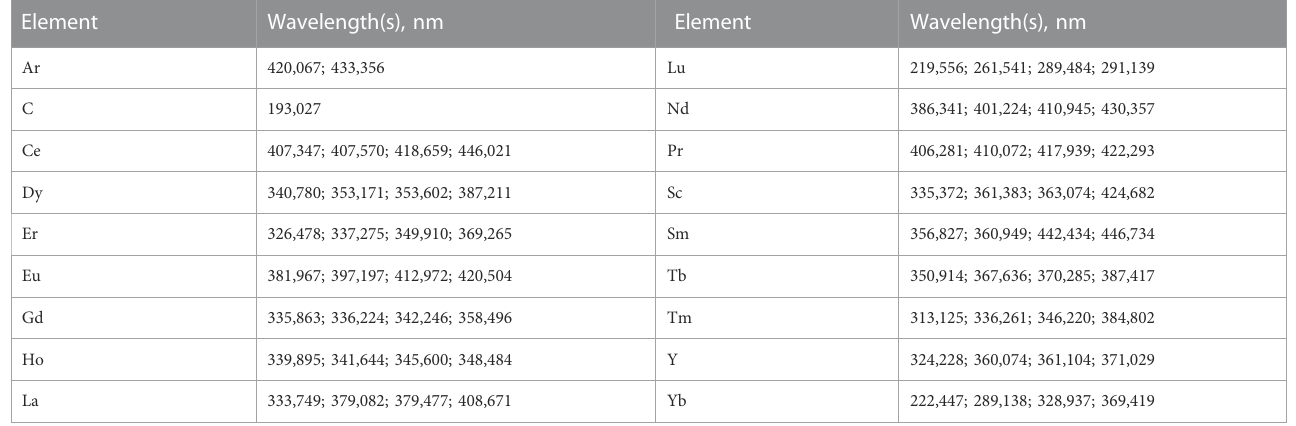
TABLE 3 Wavelengths used for the ICP-OES measurement of